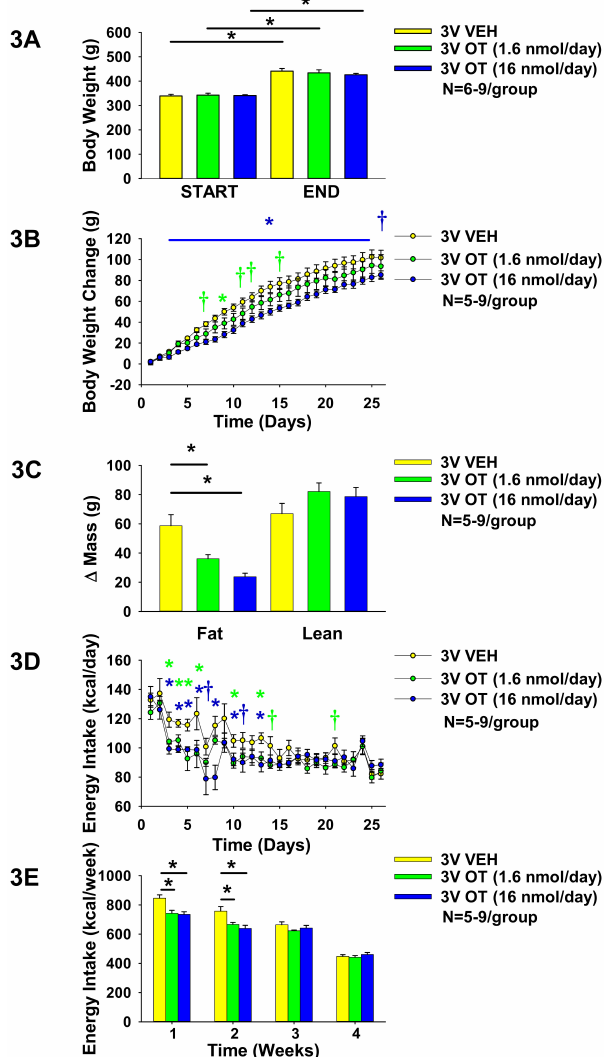
Figure 3. ( A – E ). Effects of chronic 3V OT infusions (1.6 or 16 nmol/day) on food intake, body weight gain, and body composition in male HFD-fed Long–Evans rats. Ad libitum-fed rats were placed on HFD (60% kcal from fat (Research Diets, Inc., D12492); N = 5–9/group) at onset of continuous 3V infusions of vehicle or OT (16 nmol/day). ( A ), Body weight before and after chronic 3V treatment in animals maintained on the HFD. ( B ), Cumulative change in body weight throughout course of chronic 3V treatment in animals maintained on the HFD. ( C ), Change in fat mass and lean mass before and af- ter chronic 3V treatment in animals maintained on HFD. ( D ), Change in daily energy intake (kcal/day) in animals maintained on HFD. ( E ), Cumulative change in weekly energy intake (kcal/week) in animals maintained on HFD. Note week 4 data represent energy intake data over 5 days.